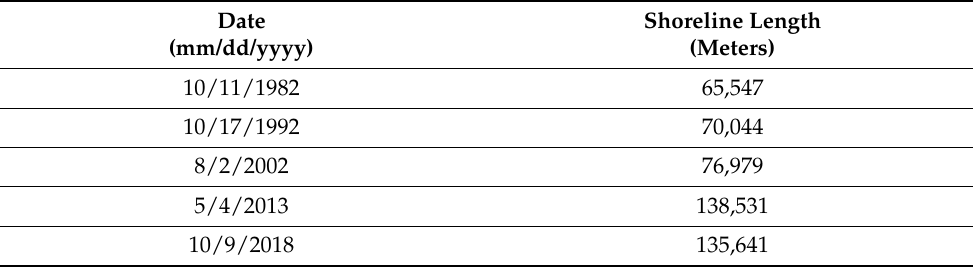
Table 3. Shoreline length of the study